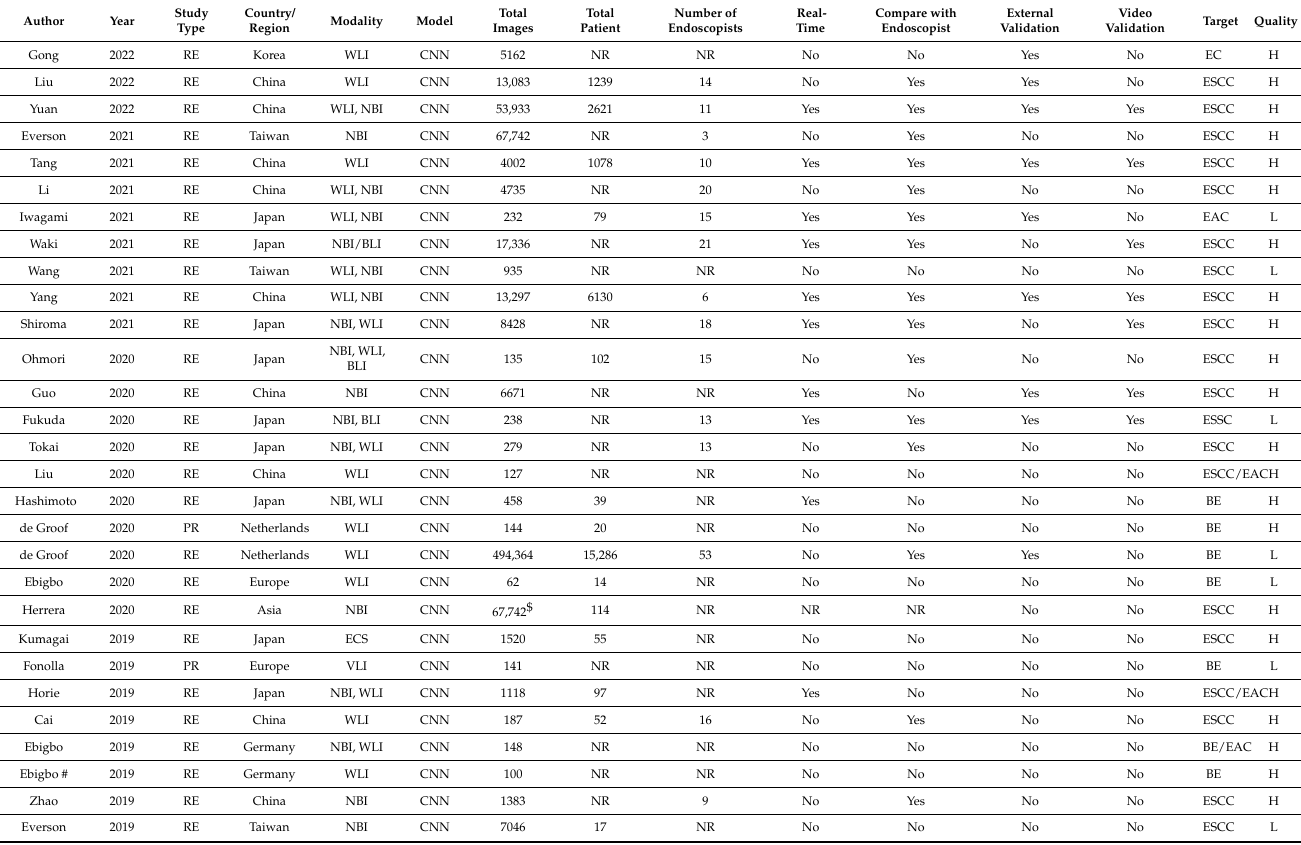
Table 1. The characteristics of the included studies.